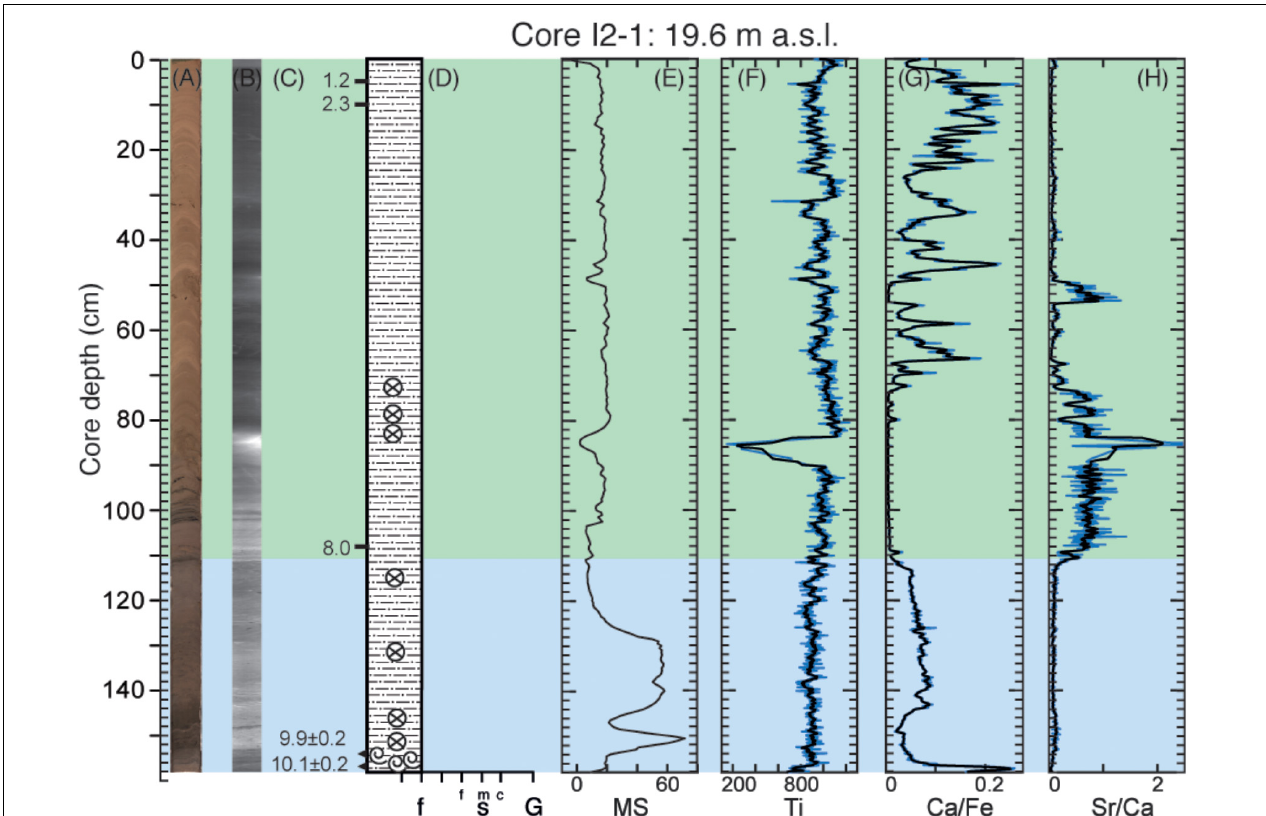
FIGURE 7 | Overview of Core I2-1. (A) High-resolution image of the core. (B) X-ray image. (C) Age and position of radiocarbon dates from foraminifera (black triangles) and ages inferred from paleomagnetic correlation (black lines). (D) Lithologic log with grain sizes from fines (clay, silt) to sand and gravel. (E–H) Magnetic susceptibility measurement and content of Ti; Ca to Fe ratio; Sr to Ca ratio. Blue background color indicates marine conditions, green indicates lacustrine. Refer to Figure 2 for